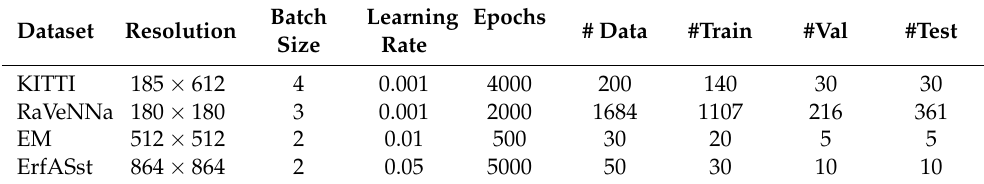
Table 3. Training parameters for each dataset. Train, val, test denote the data split used during